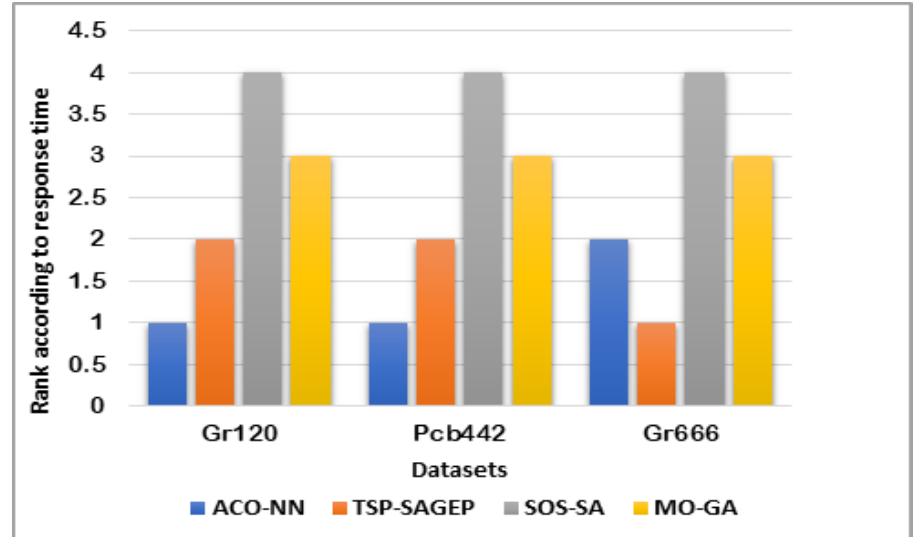
Figure 14. Comparison of rank values for ACO-NN, TSP-SAGEP, SOS-SA, and